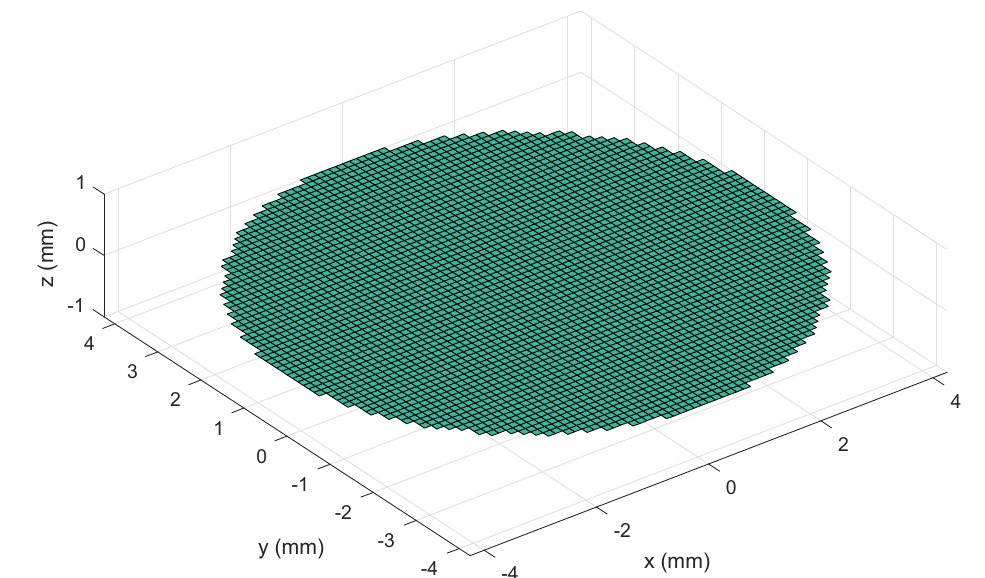
Figure 2. Emitting transducer: circular and planar piston transducer with a diameter of 8.5 mm divided into 0.125 × 0.125 mm 2 square mathematical elements.